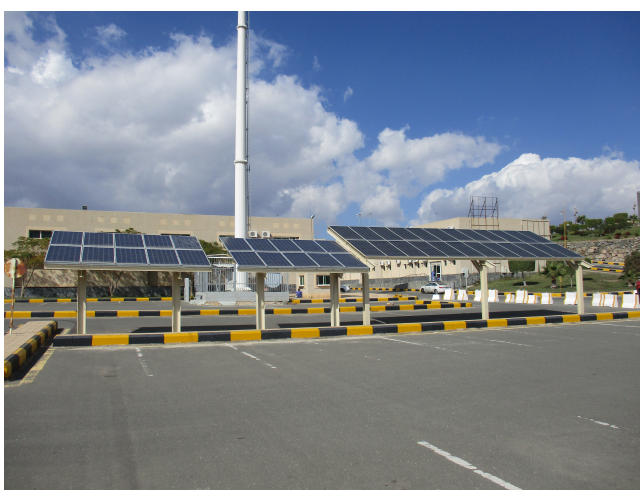
Figure 2. The Installed solar PV system at